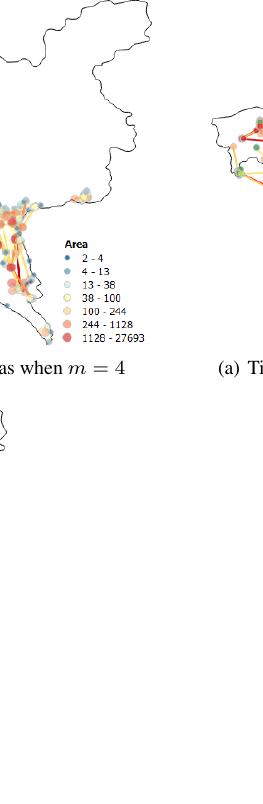
Figure 9. Time-based location of zones associated with their trajectories between July 31 and August